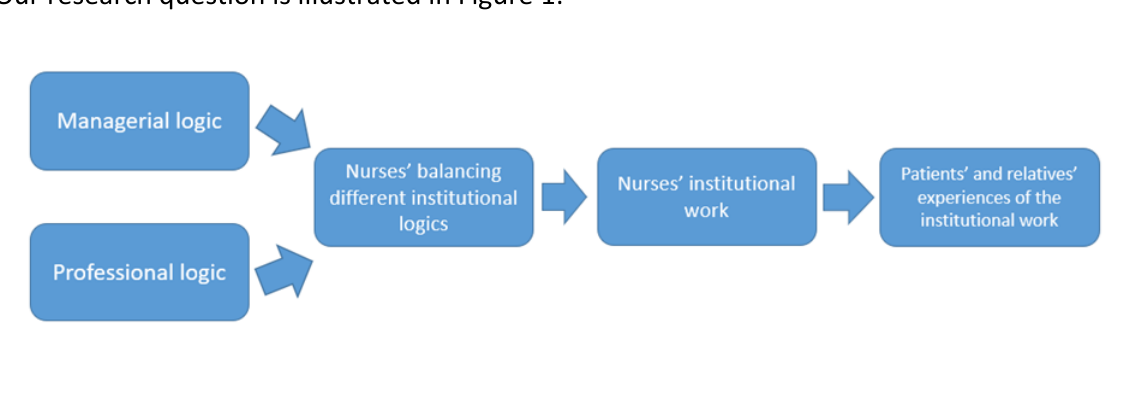
Figure 1: Experiences of different institutional logics and institutional